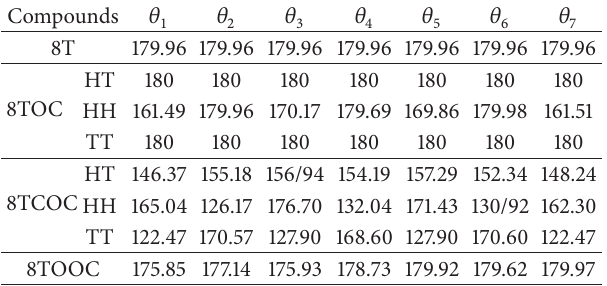
Table 2: Values of dihedral angle 𝜃 𝑖 ( ∘ ) of the studied compounds obtained by B3LYP/6-31G(d,p)